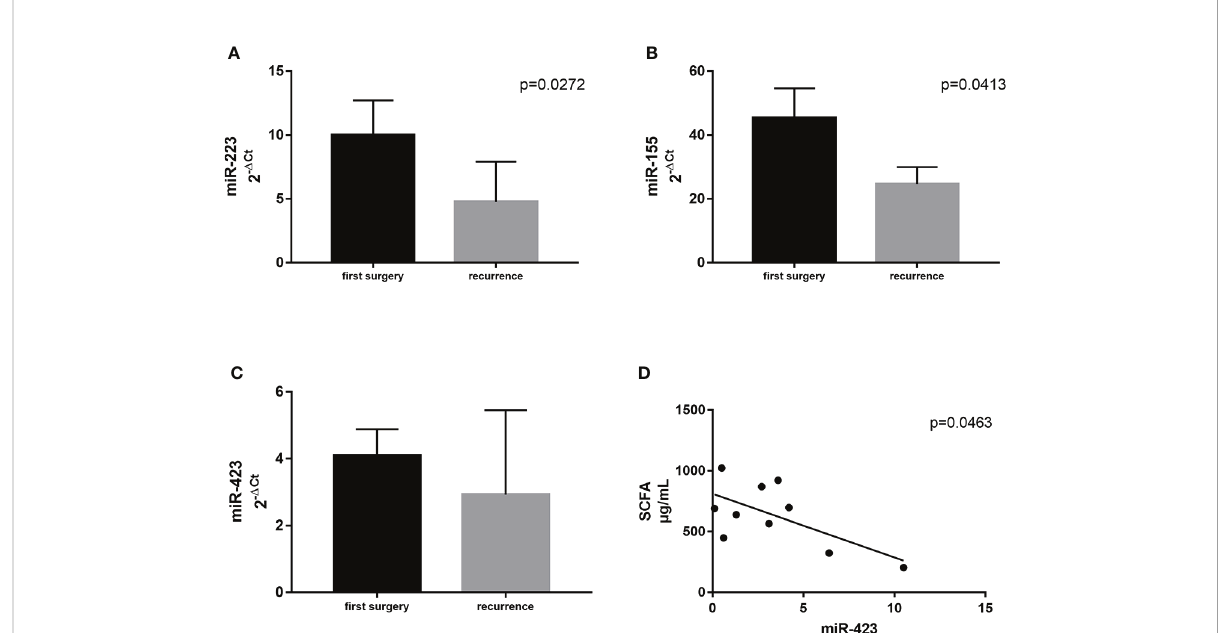
FIGURE 7 Expression levels of miR – 223 (A) and miR – 155 (B) in plasma samples from CD patients with surgical recurrence ( n = 12) compared to those at fi rst surgery ( n = 16). Correlation between plasma levels of miR – 423 and the total amount of SCFA in the serum of the same patient (C) . (D) Correlation between SCFA and miR – 423. Data are expressed as mean ± SD.